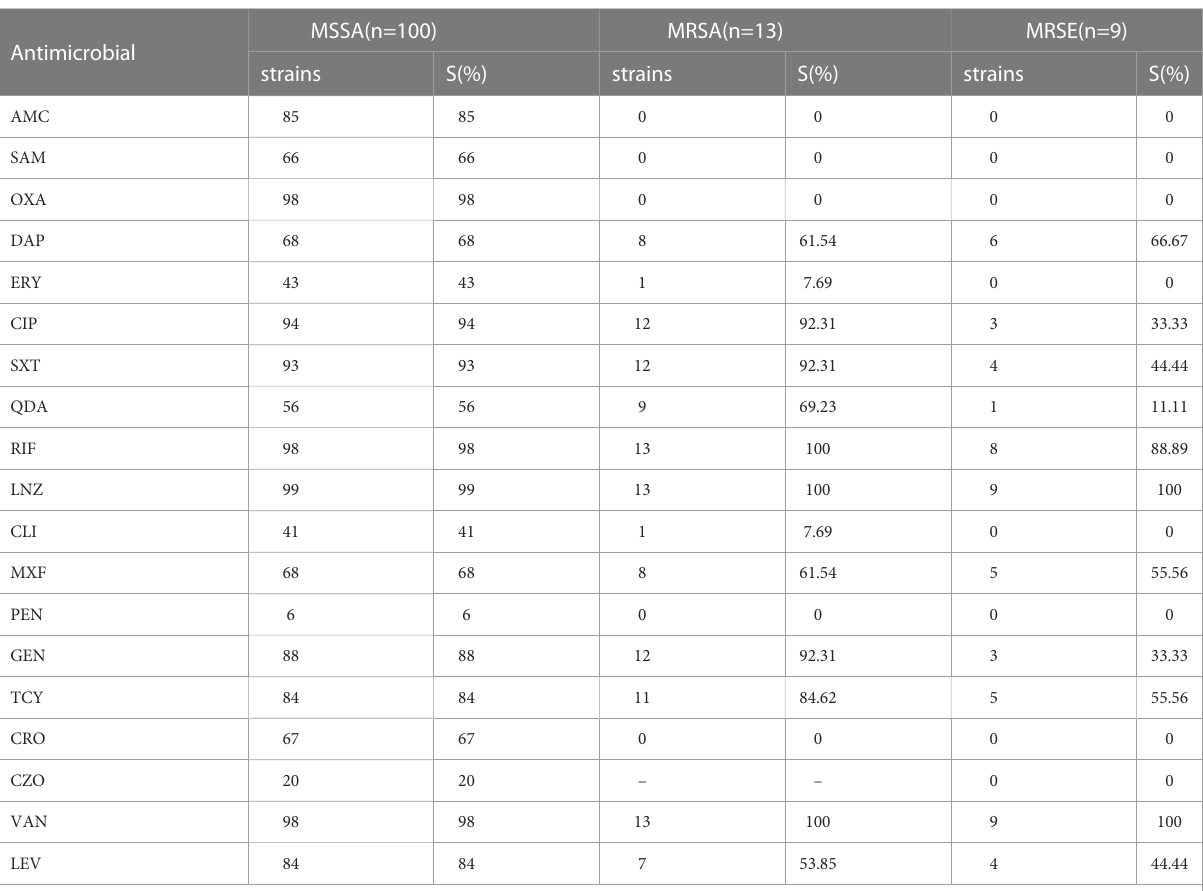
TABLE 4 Antimicrobial resistance of the main Gram-positive bacteria.